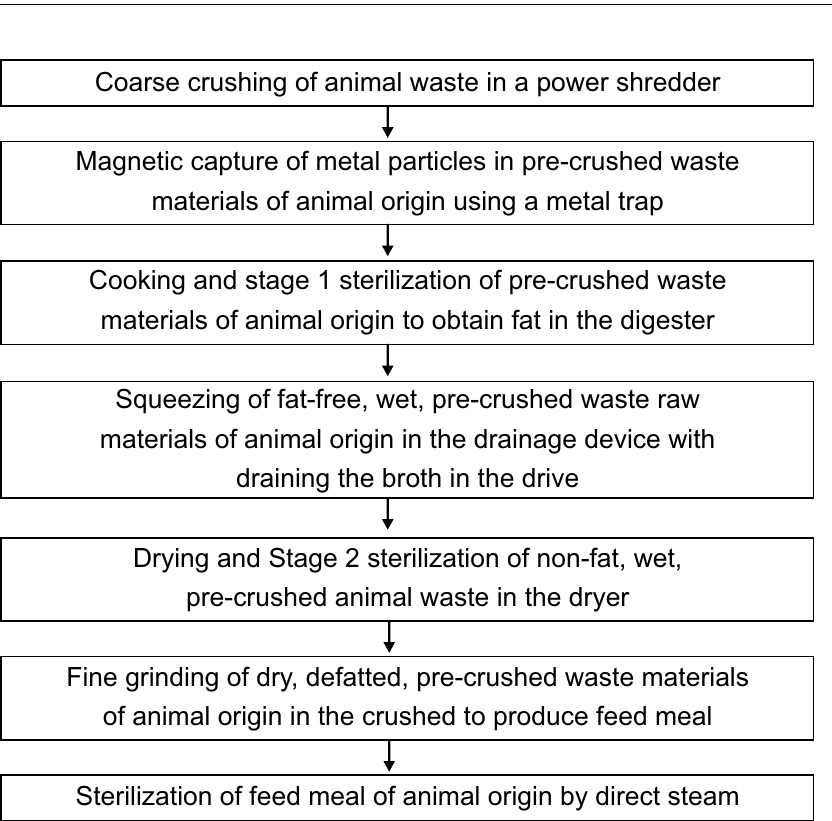
Fig. 1. Diagram of technology for processing waste materials of animal origin